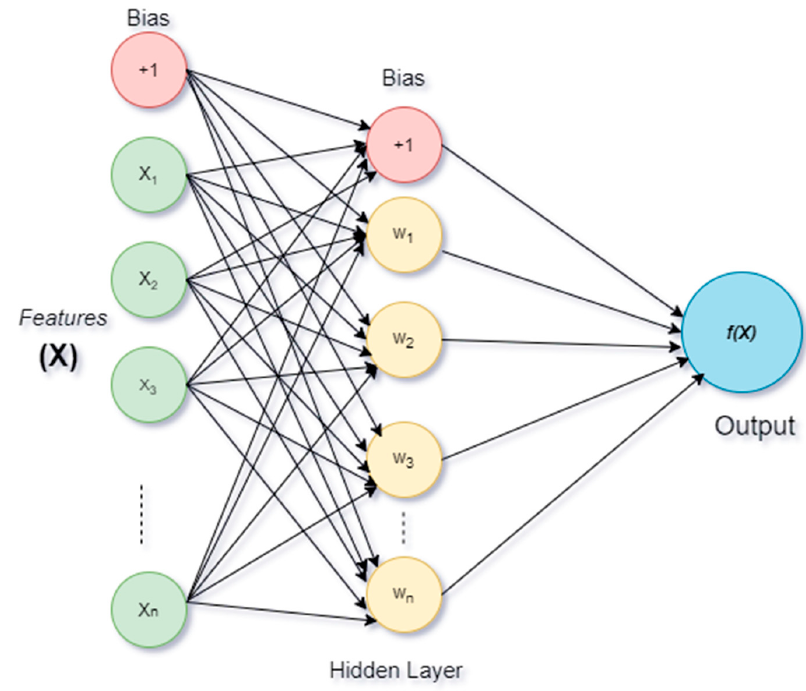
Figure 2. MLP architecture with one